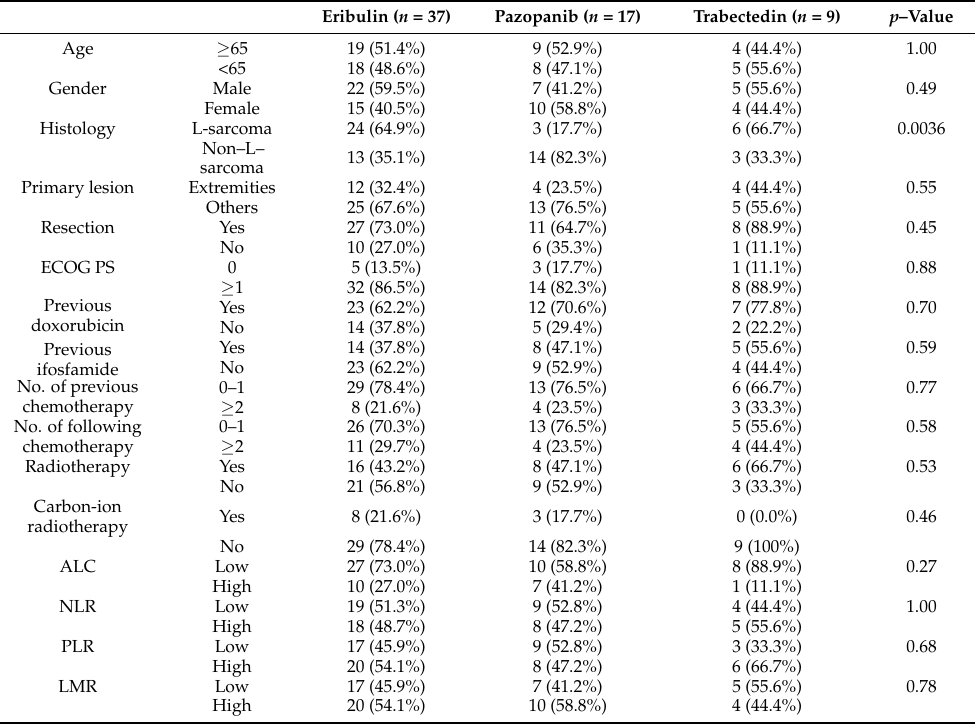
Table 1. Baseline demographics of the study patients (n =